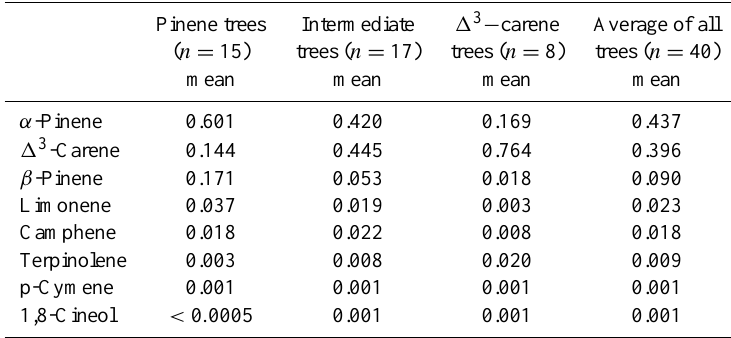
Table 1. Average proportions of monoterpenes from emission in the data set by Bäck et al. (2012) from three different tree chemotypes, and the average of the whole data